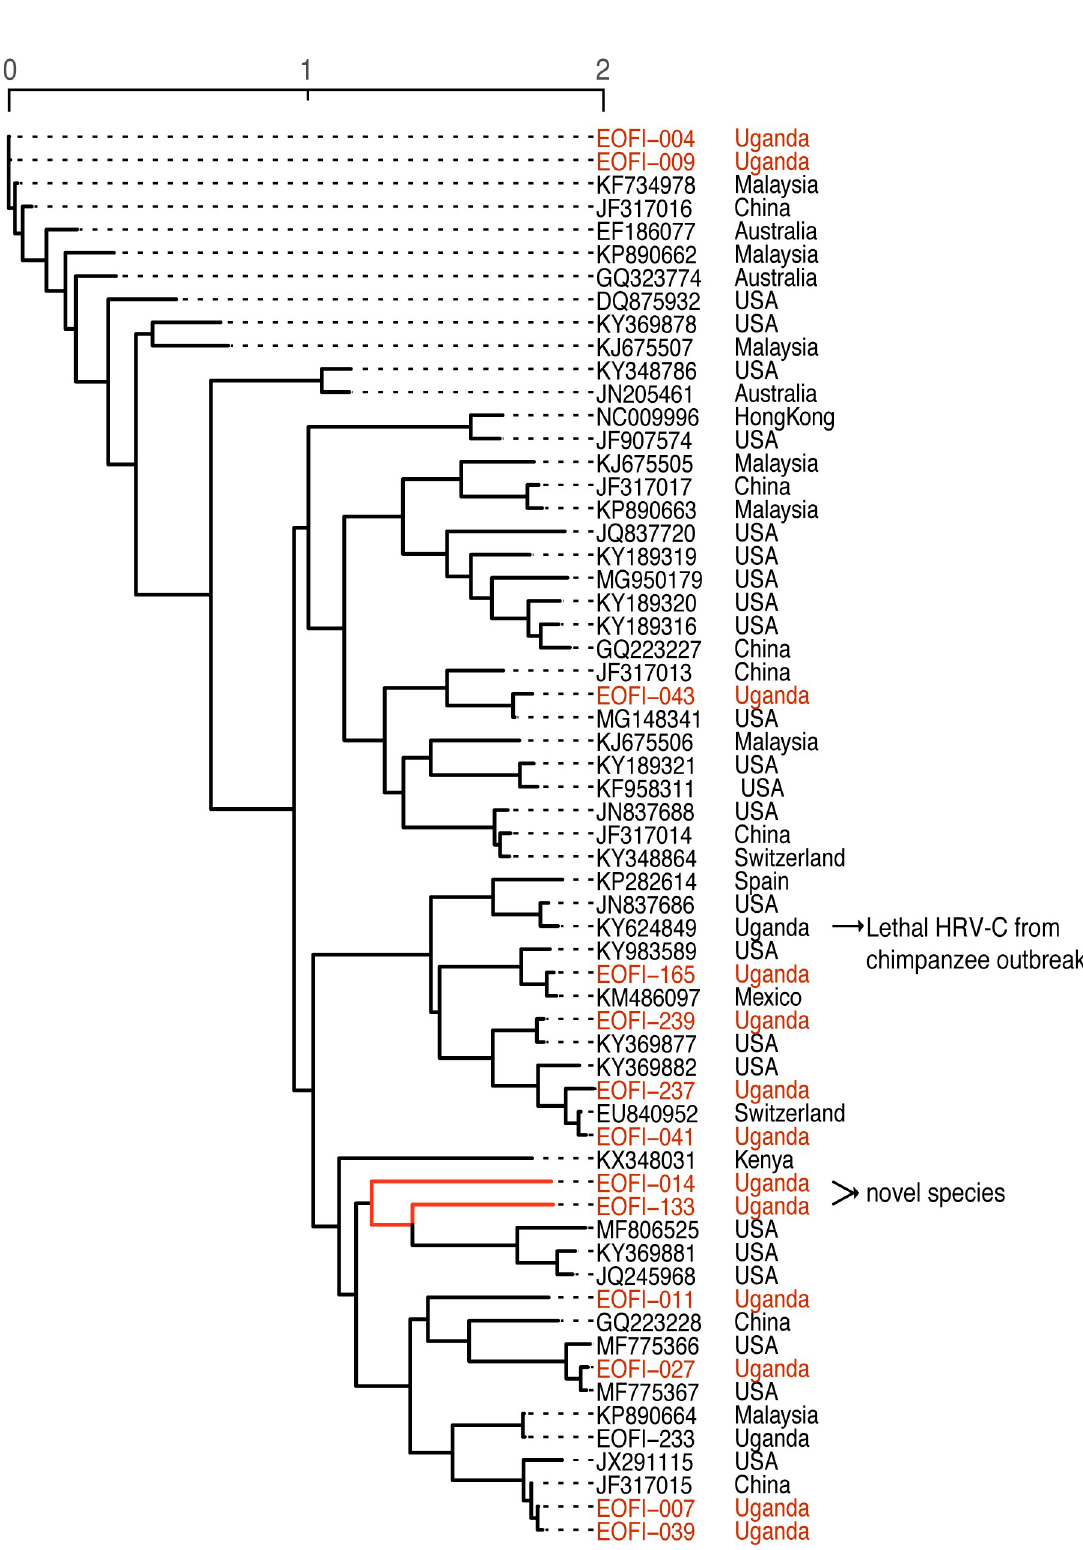
Fig 3. Phylogenetic tree of all complete HRV-C genomes from NCBI (with information on country of isolation) and HRV-C genomes assembled in this study.